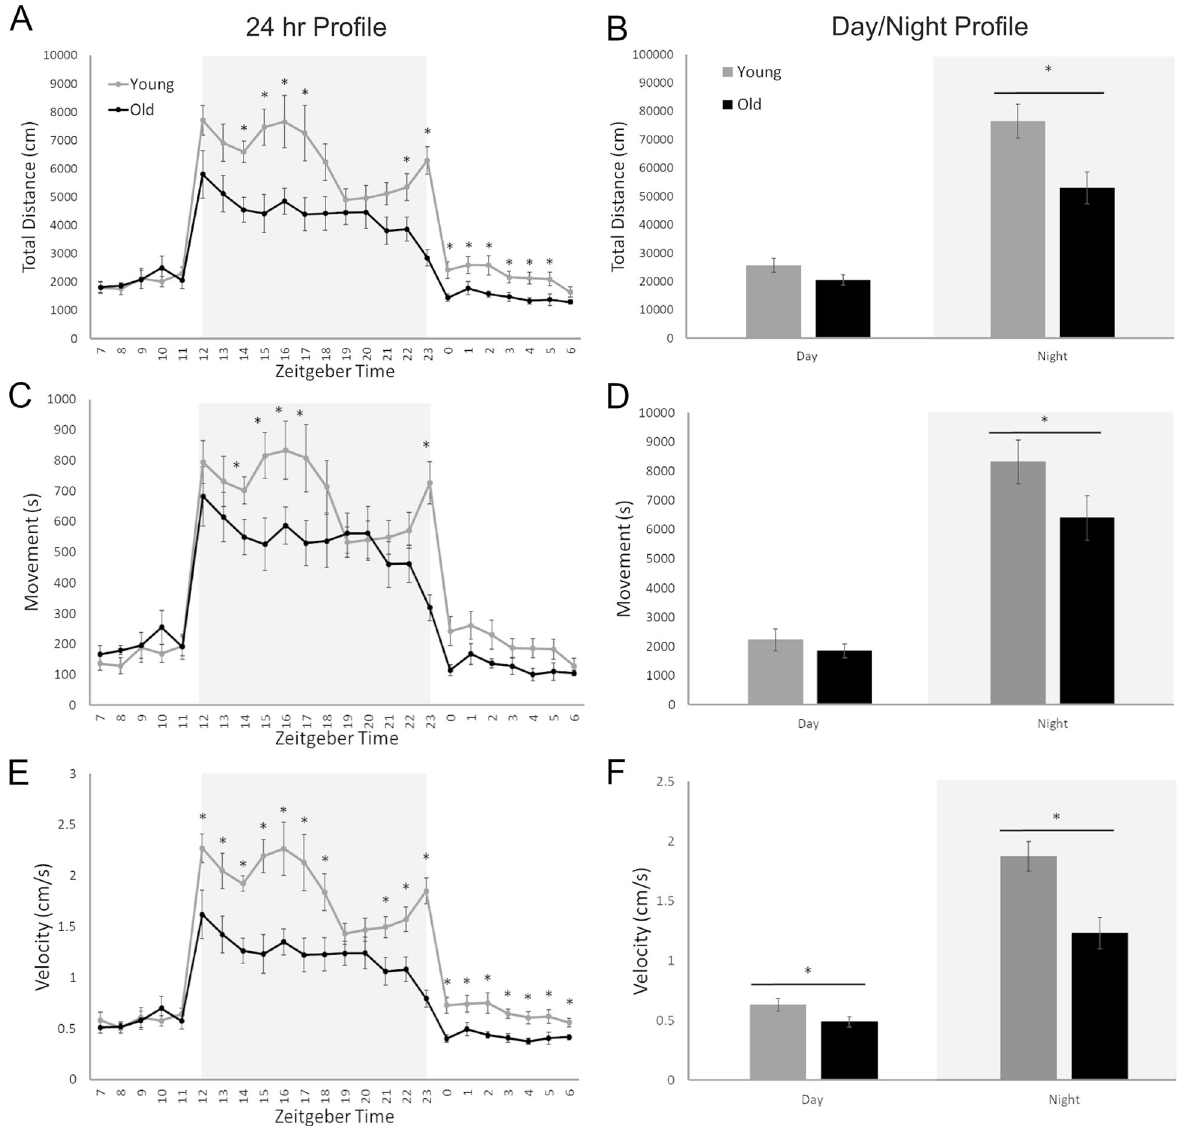
Fig. 1 The effects of age (6 weeks vs. 18 months) on general activity levels using three variables: distance (cm), time spent in movement (s), and velocity (cm/s). Light gray blocks indicate night while white sections of the graph correspond with the day, ZT0 is light on. Distance traveled in centimeters showed signi fi cantly higher values for young mice in 24 h ( A ) and Day/Night ( B ) pro fi les. The 24 h pro fi le had signi fi cantly higher distance traveled during both the night and day, however when the data were binned into 12 h night and day values, only the nighttime differences were signi fi cant. Movement time in seconds showed signi fi cantly higher values for young mice in 24 h ( C ) and Day/ Night ( D ) pro fi les. For this variable, the timepoints with signi fi cant differences were only during the night for both 24 h and day/night pro fi les. Velocity in centimeters per second showed signi fi cantly higher values for young mice in 24 h ( E ) and Day/Night ( F ) pro fi les. Unlike the previous two variables there were signi fi cantly difference during both the night and day for 24 h and day/night pro fi les. * p <